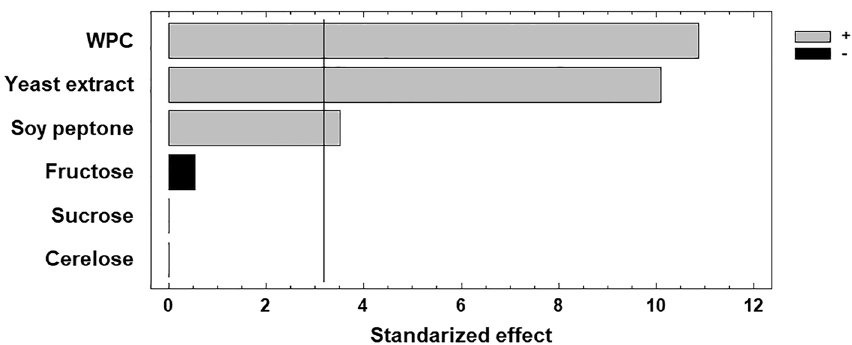
Figure 2. Pareto chart of the effects of six medium components on the biomass production of L. sakei ACU-2. The standardized effects of the variables are represented as a single column. The vertical line through the column indicates whether the variables are statistically significant. ( ■ ) Positive effect, ( ■ ) Negative